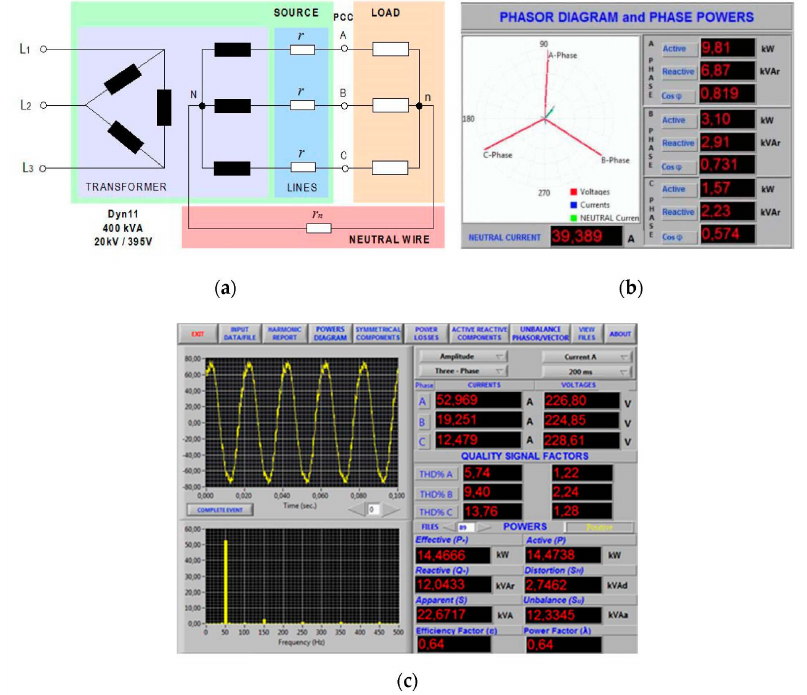
Figure 2. Real-world urban installation: ( a ) schematic representation; ( b ) active and reactive power; ( c ) main screen of the SIMPELEC nalyser representing the waves and harmonics of line currents. As the neutral conductor disrepair can be dangerous for loads, the e ff ects of the neutral